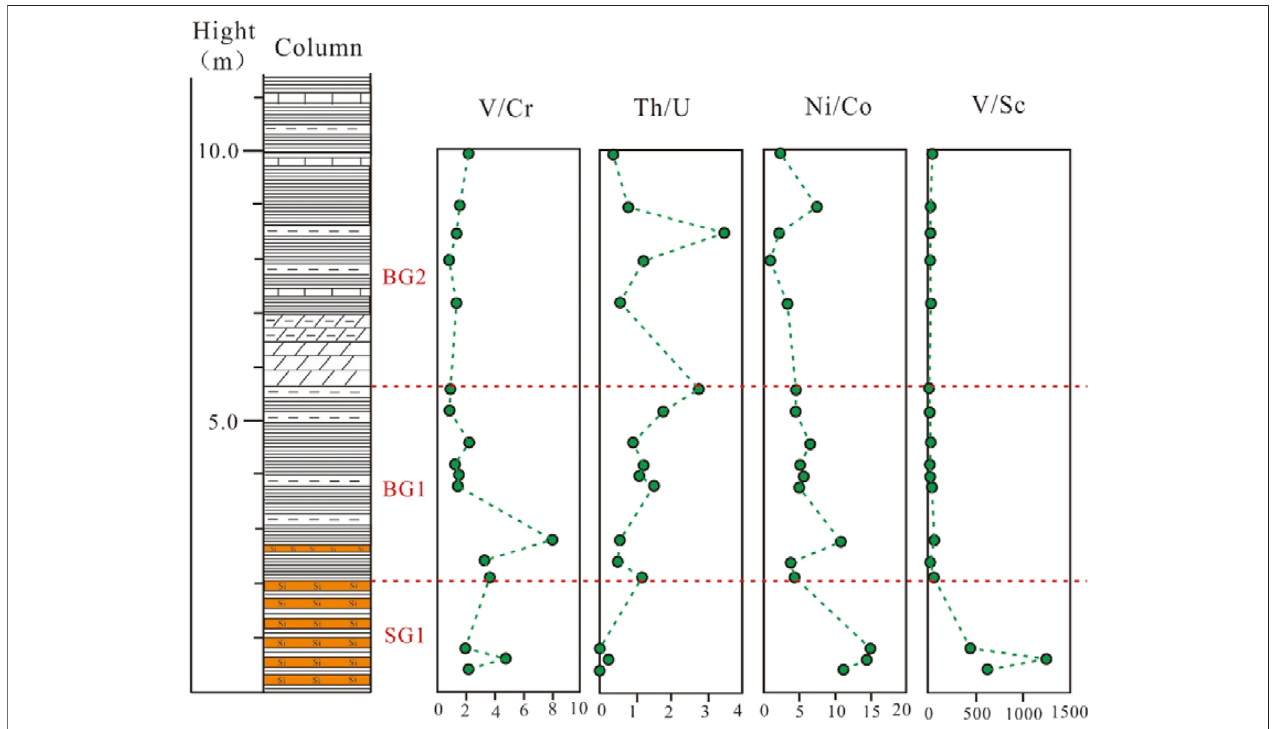
FIGURE 8 | Distribution diagram of trace element-related parameters in the Yuertusi Formation along with depth in the Yutixi outcrop.